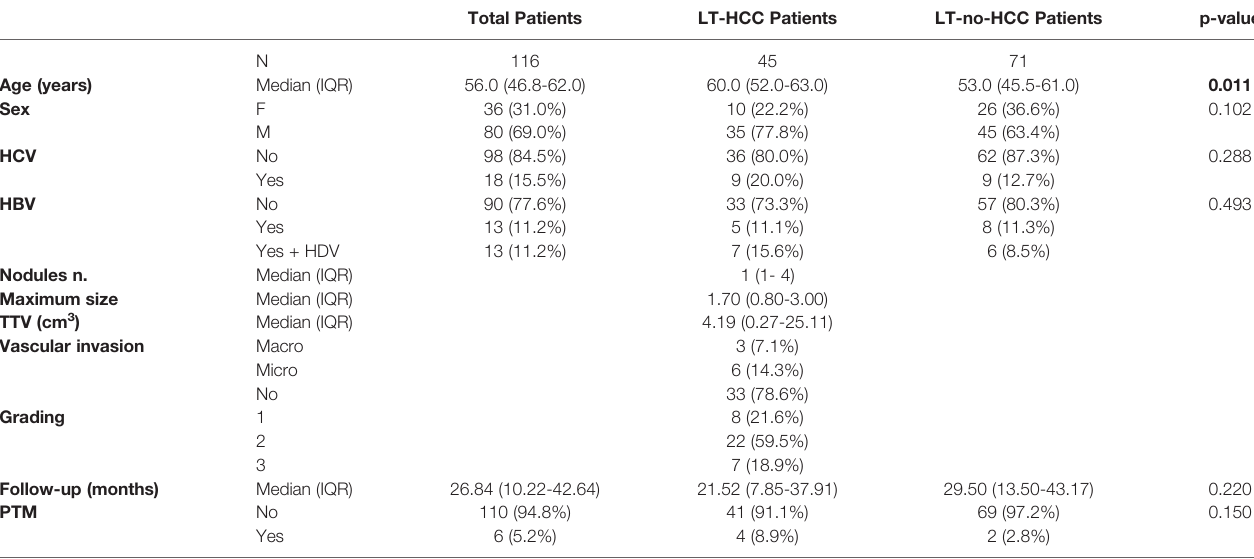
TABLE 1 | Characteristics of LT-HCC and LT-no-HCC patients.